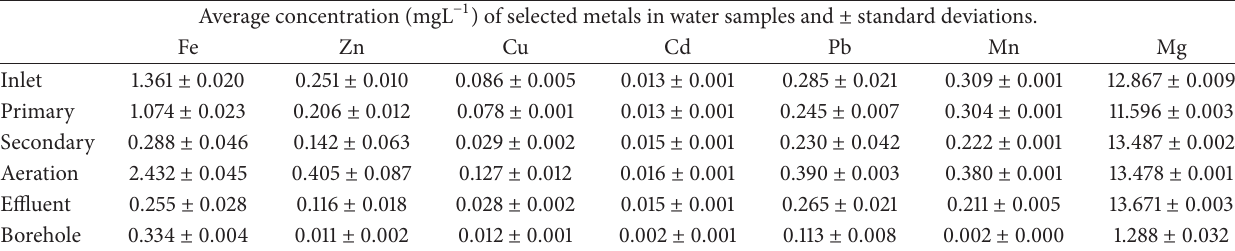
Table 2: Concentration (mgL −1 ) of selected metals in water samples. Average concentration (mgL −1 ) of selected metals in water samples and ± standard